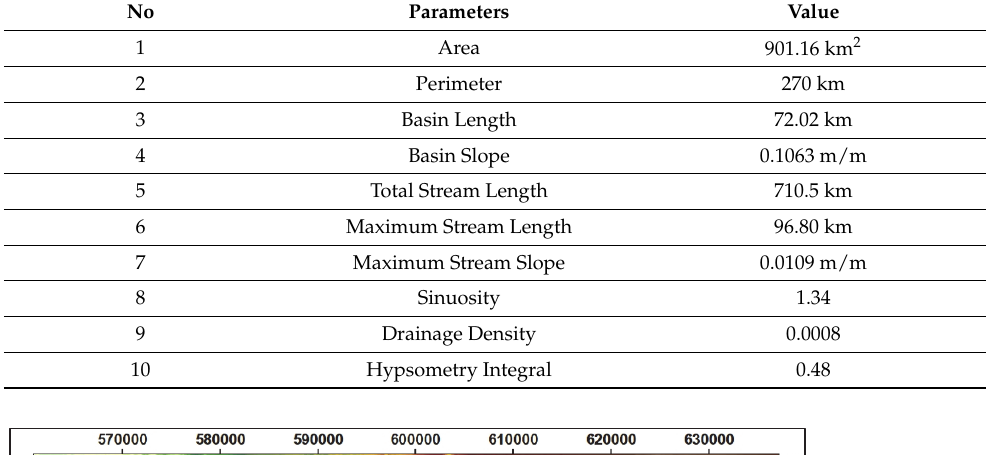
Table 1. Morphometric information of Al ‐ Lusub watershed.